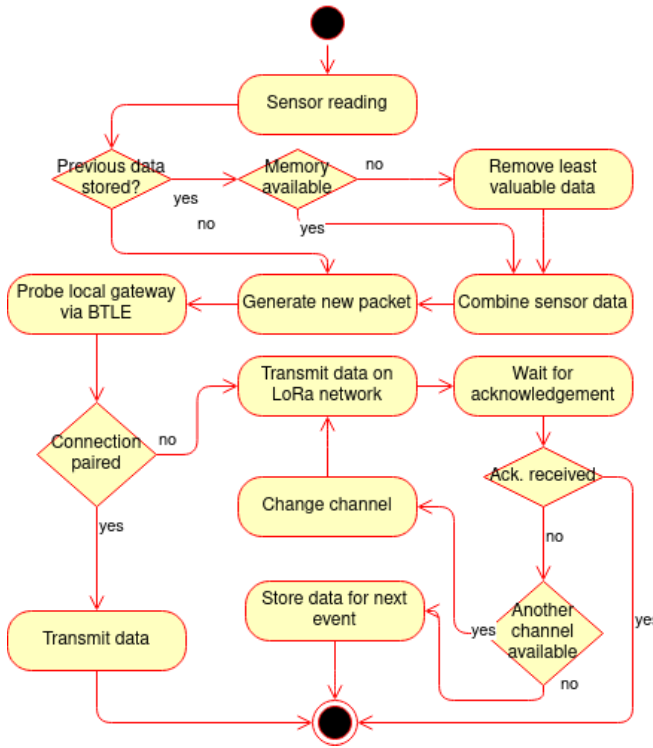
Figure 2. Data transmission decision process